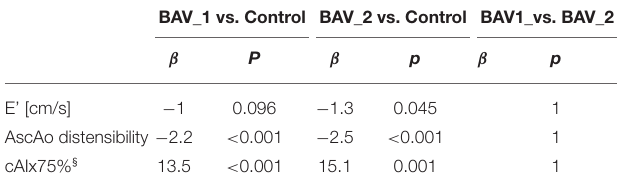
TABLE 3 | Subgroup analysis of BAV patients with native aortic valves (i.e., TABLE 4 | Subgroup analysis comparing BAV patients with native well-functioning excluding 15 patients who have undergone prior aortic valve replacements) valves (BAV_1; n = 22) and BAV with prior intervention (BAV_2; n = 19) to compared to controls. β P